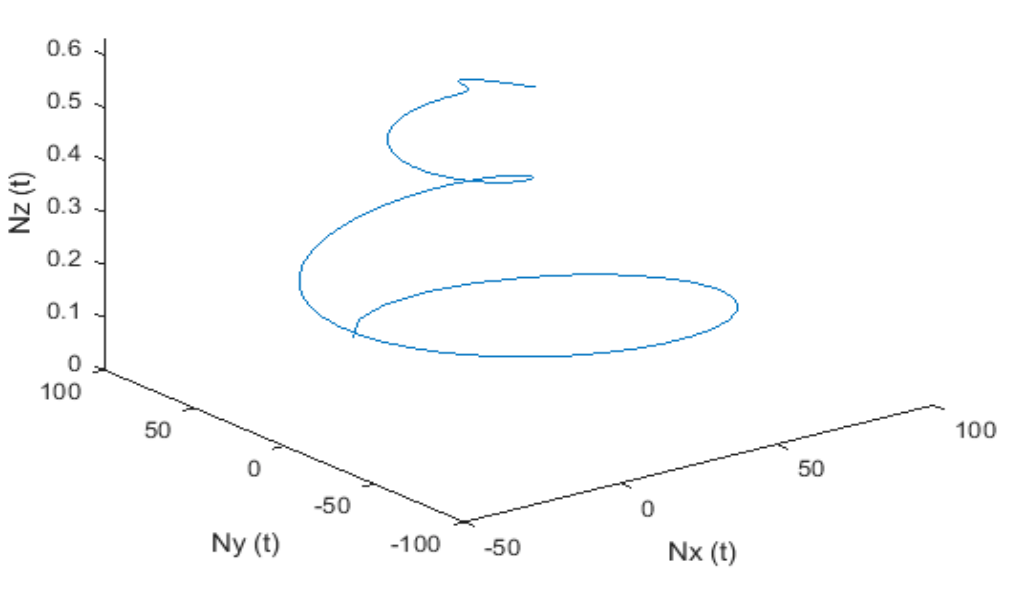
Figure 11. Numerical solutions of the Bloch equation with parameters: α = 0.9, β = 0.9, γ = 1, w 0 = 12, T 1 = 1, T 2 = 20, a = 1, b = 1.